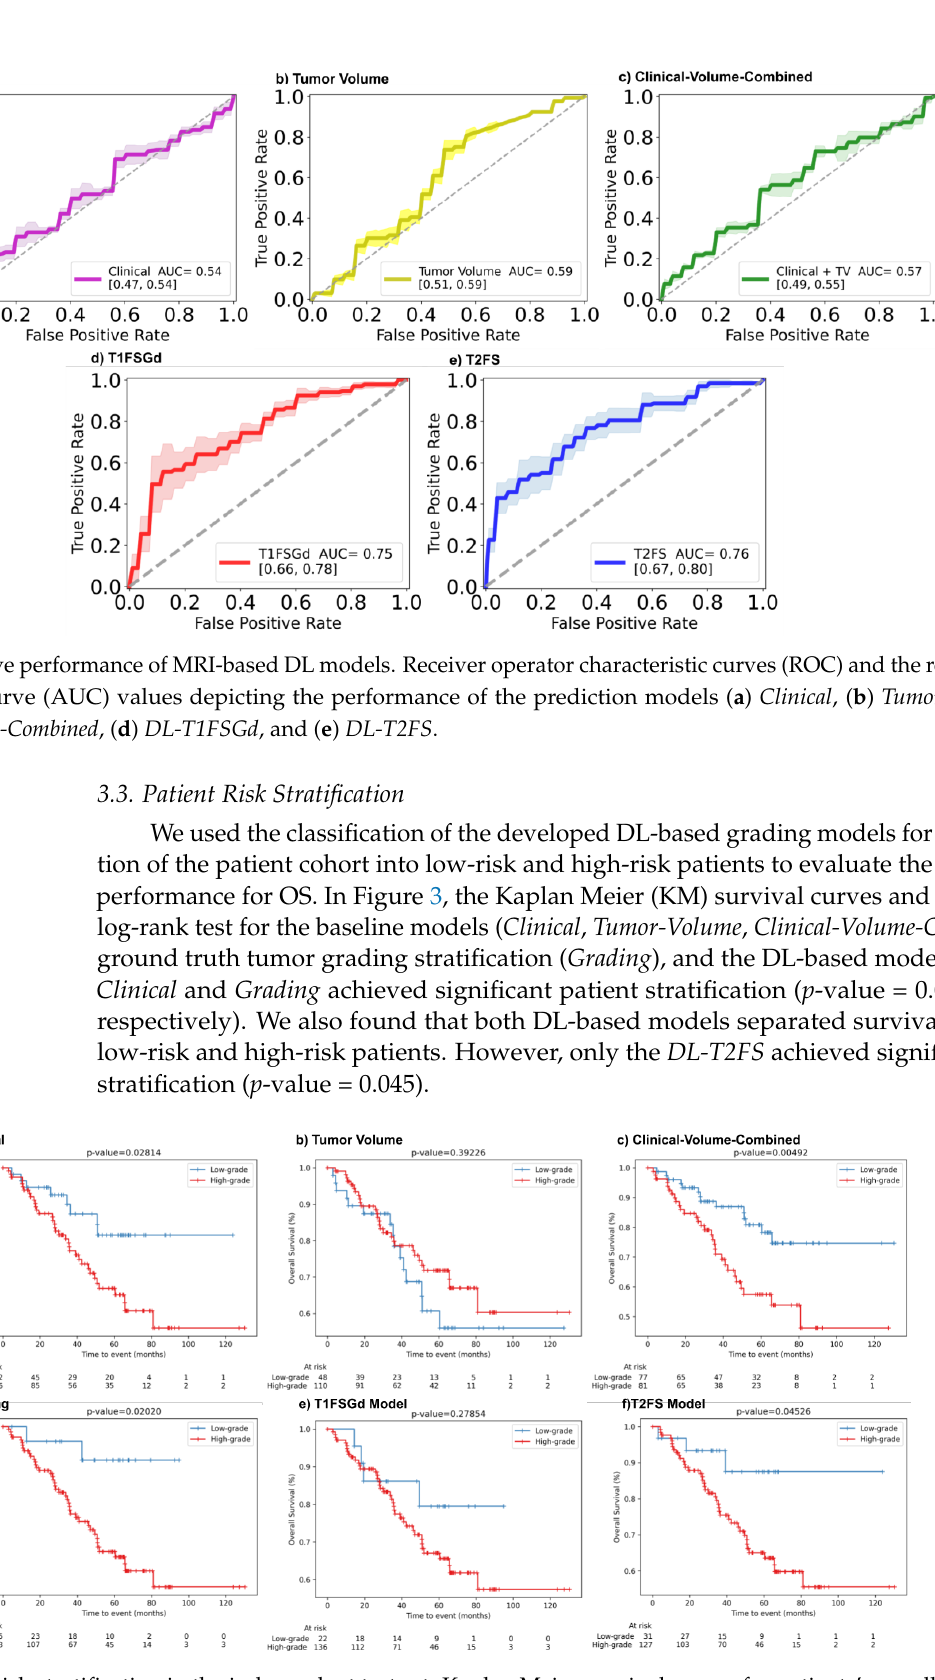
Figure 3. Patient risk stratification in the independent test set. Kaplan Meier survival curves for patients ’ overall survival displaying risk stratification of the developed models on the test cohort. ( a ) Clinical , ( b ) Tumor-Volume , ( c ) Clinical-Volume-Combined , ( d ) Grading (low-grade vs. high-grade), ( e ) DL-T1FSGd , and ( f ) DL-T2FS . Depicted p-values describe the results of the log-rank test.